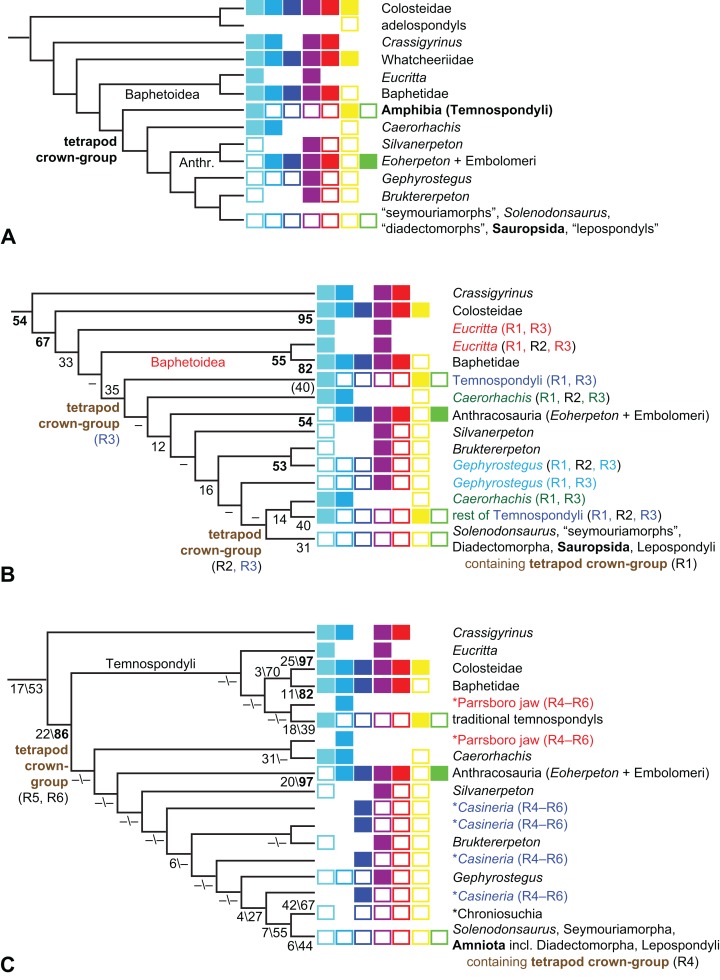
Hypotheses on the relationships of post-Devonian limbed vertebrates, and distribution of several character states.(A) RC07; the entire clade shown here equals the “post-Devonian limbed vertebrates” of Fig. 23A. Anthr., Anthracosauria. (B) Our results from the original taxon sample (R1–R3). The entire clade shown here equals the “other post-Devonian limbed vertebrates” of Fig. 23B. Numbers are BPO, in boldface if 50 or higher. Analysis B1 finds Caerorhachis next to the other temnospondyls, but places Temnospondyli in the more rootward of the two indicated positions and also finds Silvanerpeton next to the other anthracosaurs (BPO: 10). (C) Our results from the expanded taxon sample (R4–R6). The entire clade shown here equals the “other post-Devonian limbed vertebrates” of Fig. 23C. In (B) and (C), the extant amphibians are shown indirectly as the three positions of the tetrapod crown-group; although not rendered in boldface, “(rest of) Temnospondyli” is extant in R2, R3, R5 and R6, and “Lepospondyli” is extant in R1, R3, R4 and R6. Parentheses show which of these positions are found in which analyses. The numbers of these analyses are written in black if these analyses find a single position; for any position found as the single position by any analyses, the parentheses themselves are also black. Numbers are BPE\PP, BPE in boldface if 50 or higher, PP in boldface if 75 or higher. The rectangles indicate state 0 (filled) or 1 (empty) of characters 31 (PAR 1—cyan), 147 (PSYM 1—teal), 192 (CLE 2—blue), 212 (HUM 10—purple), 214 (HUM 12-15—red), 260 (TRU VER 8—orange) and 277 (CAU FIN 1—green); absence of a rectangle means missing data. Where known, Devonian limbed vertebrates have state 0 of each of these characters. Character 31: supratemporal/postparietal suture (0) or tabular/parietal suture (1); 147: presence (0) or absence (1) of parasymphysial; 192: presence (0) or absence (1) of postbranchial lamina on cleithrum; 212: humerus not (0) waisted (1); 214: humerus L-shaped (0) or not (1); 260: absence (0) or presence (1) of fusion between left and right pleurocentra in ventral midline; 277: presence (0) or absence (1) of tail fin skeleton (supraneural radials, lepidotrichia). See App. S1 for more precise definitions and discussion. Note that, of all adelospondyls, character 260 is only known in Acherontiscus; the adelogyrinids share state 1 if their single-piece centra are pleurocentra, but they have state 0 if their centra are intercentra, a question we cannot presently decide. Although all anthracosaurs in this matrix are unknown for character 277, we here show state 0 because of **CM 34638 (Clack, 2011b). Further derivations occur within some of the composite clades shown here: the highly nested temnospondyl Micromelerpeton is polymorphic for 31, and the diadectomorph Tseajaia has state 31(0); Pederpes (nested within Whatcheeriidae) has state 192(1); Urocordylidae and the diplocaulid Keraterpeton (“lepospondyls”) have state 212(0); Eusthenopteron, Panderichthys and the embolomeres Archeria and Pholiderpeton scutigerum have state 212(1), while Limnoscelis and Orobates (Diadectomorpha) as well as the diplocaulids Keraterpeton and Diceratosaurus have state 212(0); and the highly nested temnospondyls Doleserpeton and *Gerobatrachus have state 260(1). State 2 of the ordered character 214 is not shown (Eucritta, which has state 0 or 1, is therefore shown as unknown); all the OTUs that have this state (an extra-long humerus) are nested well within clades for which 214(1) is plesiomorphic.